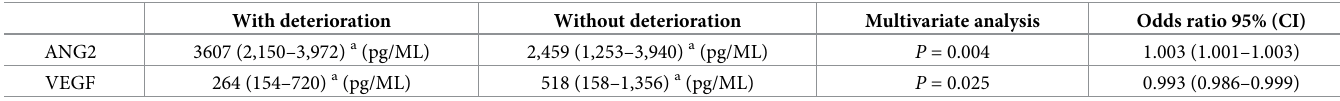
ANG2: angiopoietin 2, VEGF: vascular endothelial growth factor, CI: confidence interval. a Data are shown as median (range)